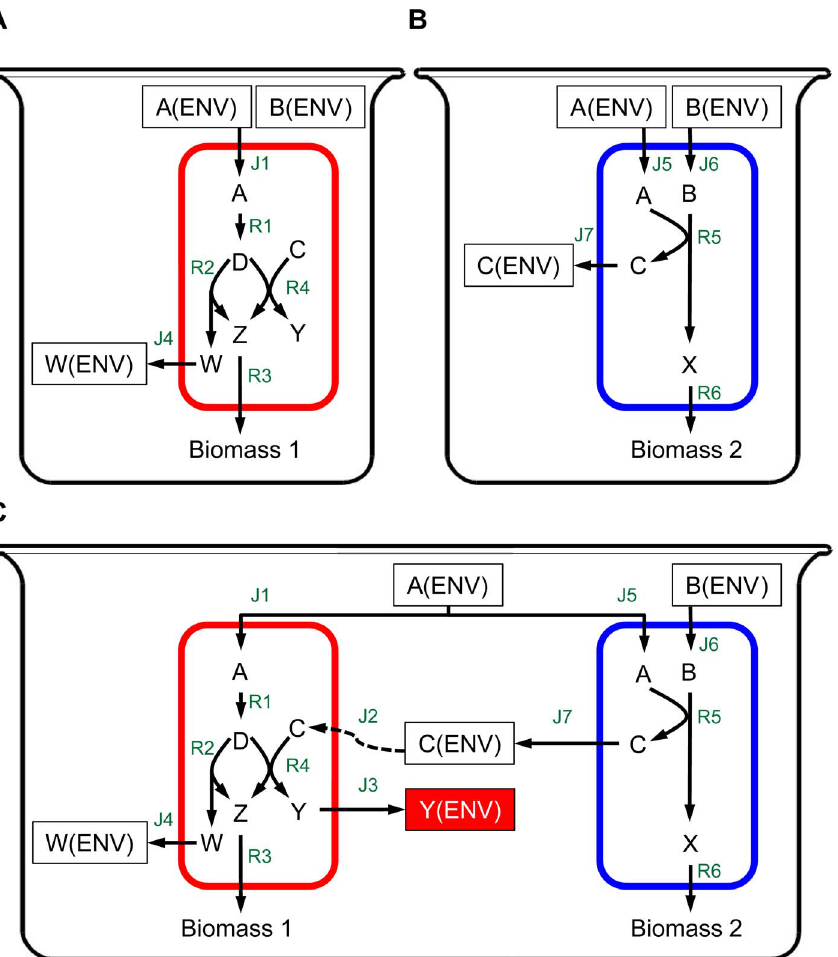
Figure 2. A toy ecosystem of emergent biosynthetic capacity. Both the red ( A ) and blue ( B ) species can successfully grow in mono-culture using the same medium that contains metabolites A and B. Yet, growing the two species in co-culture ( C ), an emergent biosynthetic capacity can be observed, as the red species utilized via cross-feeding (dashed lines) metabolite C that was secreted to the medium by the blue species, activating an alternative pathway for biomass production and secreting metabolite Y as a byproduct.